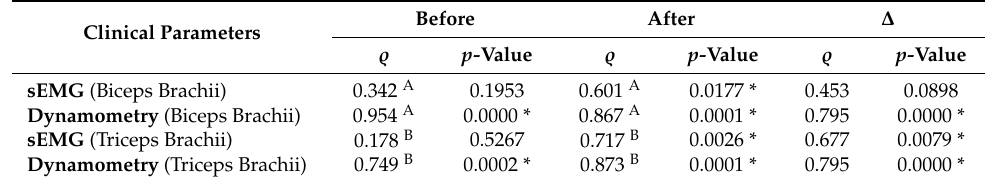
Table 2. Correlation between the MRC scale score and sEMG amplitude and Dynamometry